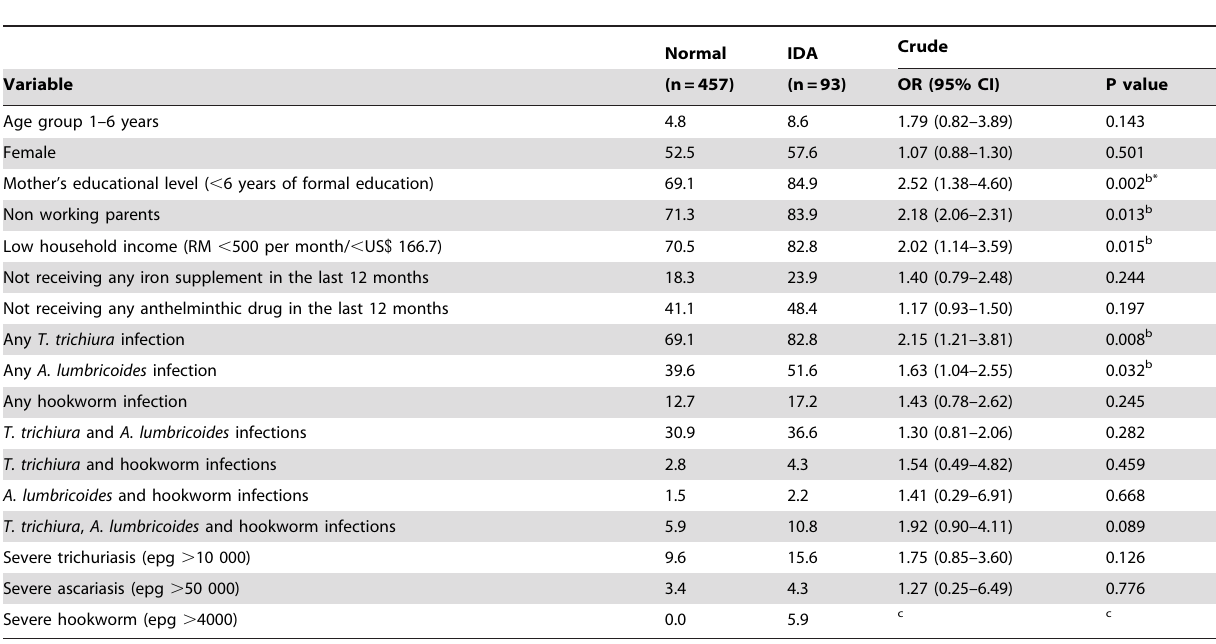
Table 4. Odds ratios of the aetiological factors for IDA among 550 rural children in West Malaysia a .